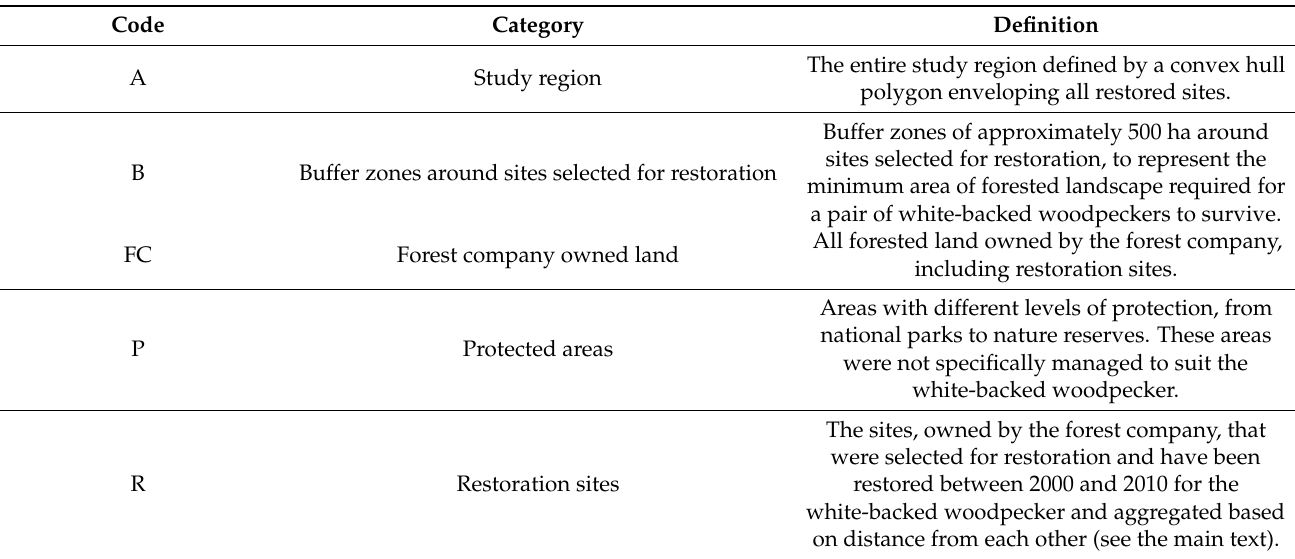
Table 1. Definitions of categories used for the